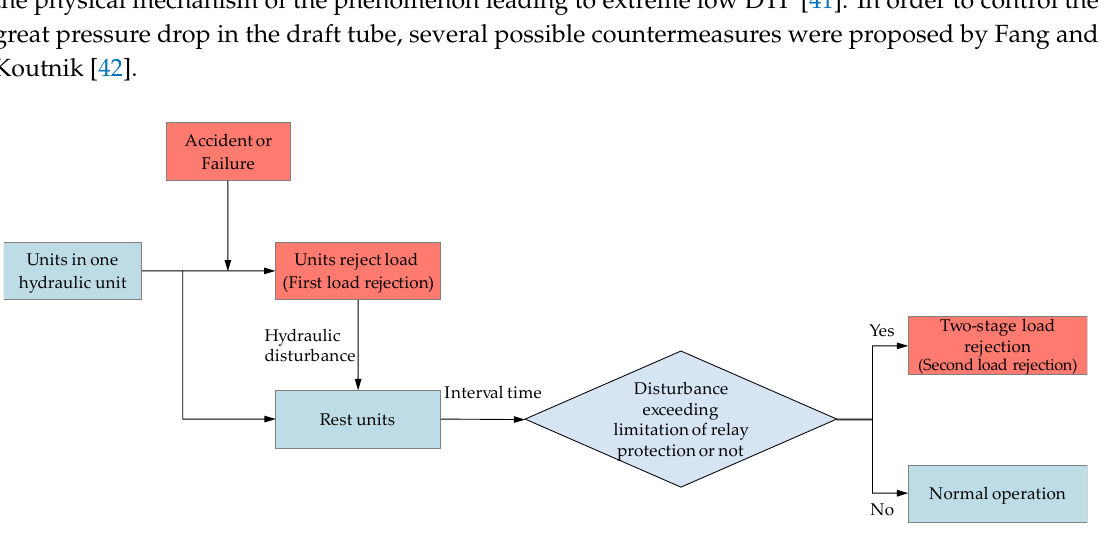
Figure 1. Schematic diagram of two-stage load rejection.